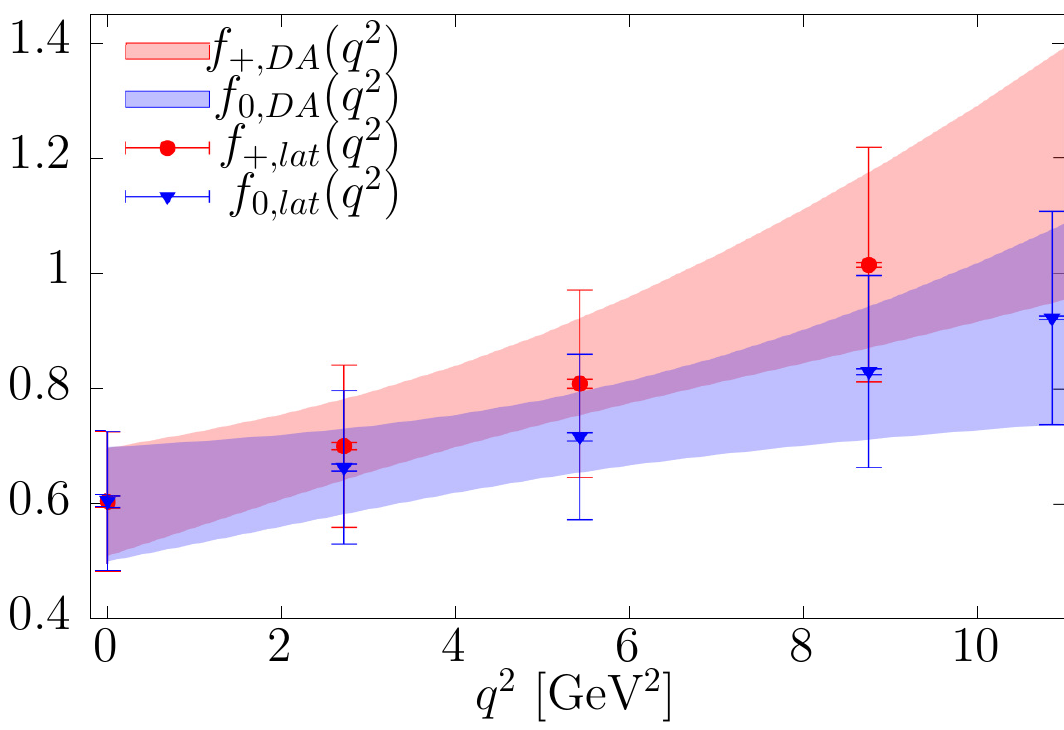
Figure 2 . B + ! (cid:17) c form factors f + ( q 2 ) (red circles) and f 0 ( q 2 ) (blue triangles) from the HPQCD c collaboration. The interior bars represent the statistical uncertainty quoted by HPQCD. The ex- terior bars represent the result of including our f lat = 20% systematic uncertainty. The colored bands DA (dispersive analysis) represent our one-standard-deviation (1 (cid:27) ) best-(cid:12)t region.